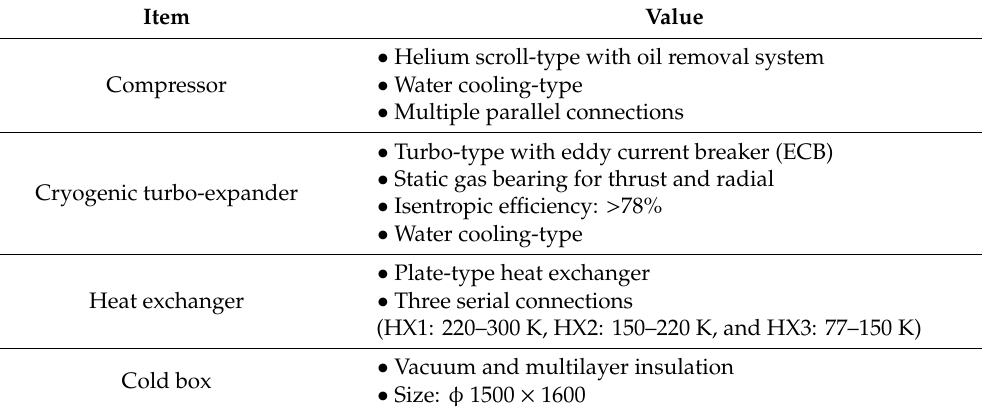
Table 4. Specifications of the main components of the reverse Brayton cryogenic